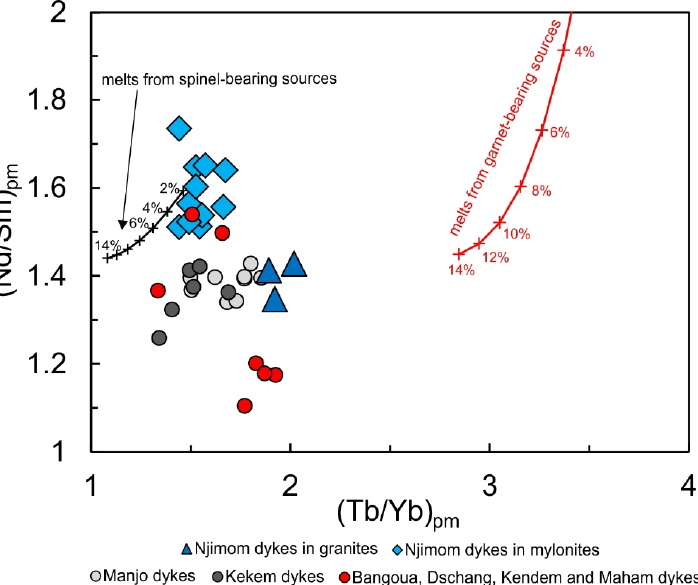
Figure 13. (Nd/Sm)pm vs. (Tb/Yb)pm diagram illustrating non-modal fractional melting models for the Njimom dykes. The values along curves are the degrees of partial melting. The composition of the source is the lithospheric mantle of [29]. Mode of the source, eutectics, and partition coefficients after [30].